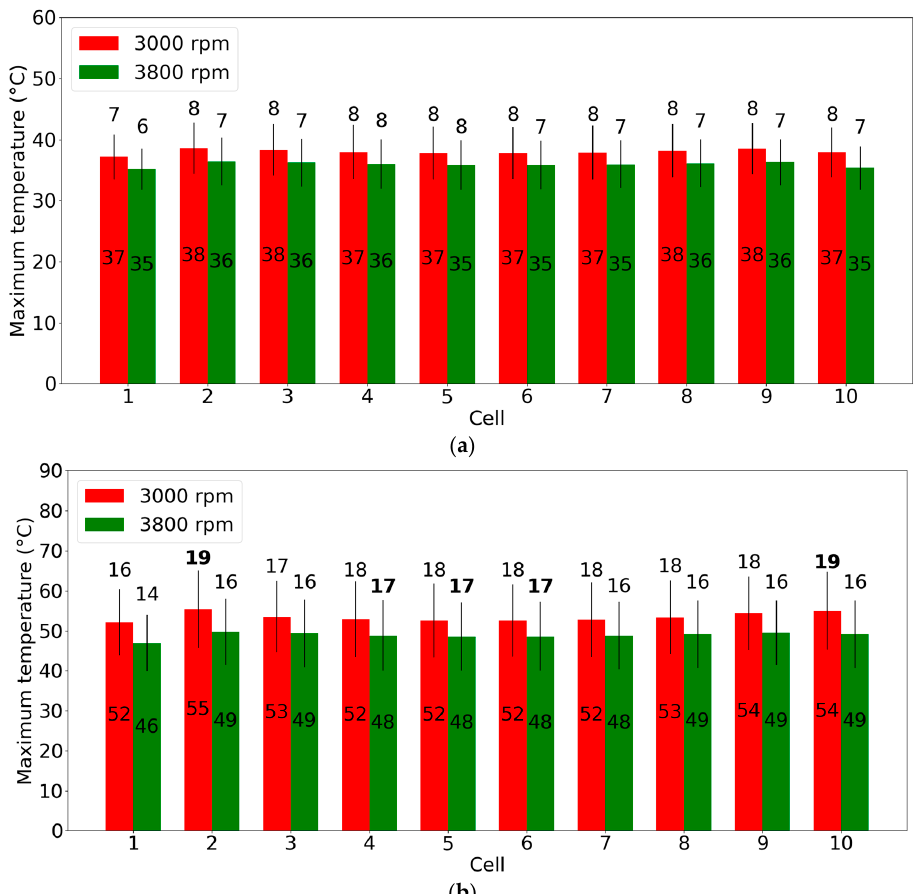
Figure 11. Maximum temperature and temperature difference for each single-battery cell in the battery module after discharging at ( a ) 3C and ( b ) 5C rates. module after discharging at ( a ) 3C and ( b ) 5C